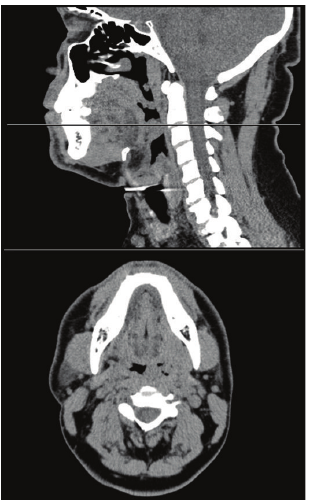
Figure 2: Noncontrast computed tomography. Sagittal and axial slices demonstrate a narrowed airway and thickening of the epiglot- tis (cursorshown for level) and subcentimeter cervical lymph